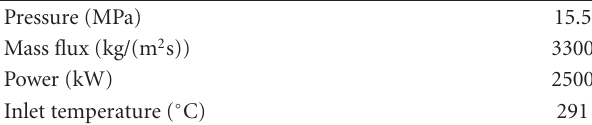
of the assembly have a relative power of 0.85, as all inner rods have a relative power of 1.0. The occurrence of DNB during the tests is detected by a rod temperature rise of 11 ◦ C measured by the ther- mocouples. The corresponding power is defined as critical power. The temperature is measured with an accuracy of 1 ◦ C, whereas the power has a measurement error of 1% [16]. The SUBCHANFLOW predictions for many tests are compared to the measured critical power in Figure 17 to Figure 22. An error band of ± 10% is indicated in the graphs. The predictions of the critical power for the tests of bundle type A0 have a standard deviation of 8 % but with a tendency to an overprediction (Figure 17). On the contrary, the critical power predictions for the bundle type A2 are generally underpredicted and several predictions are outside the error band of ± 10%. The only di ff erence between the bundle types A0 and A2 is the number of spacer of the